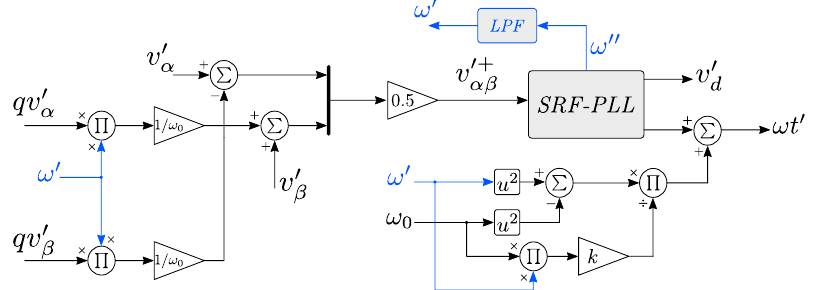
Figure 7. FFDSOGI with frequency LPF.